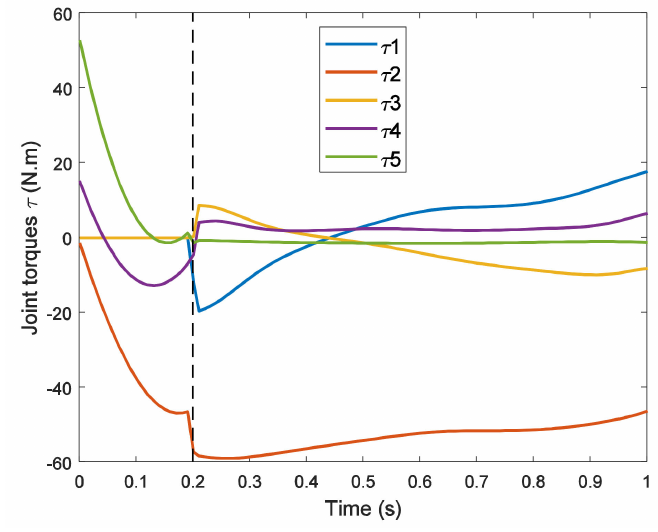
Figure 6. Torque trajectories.